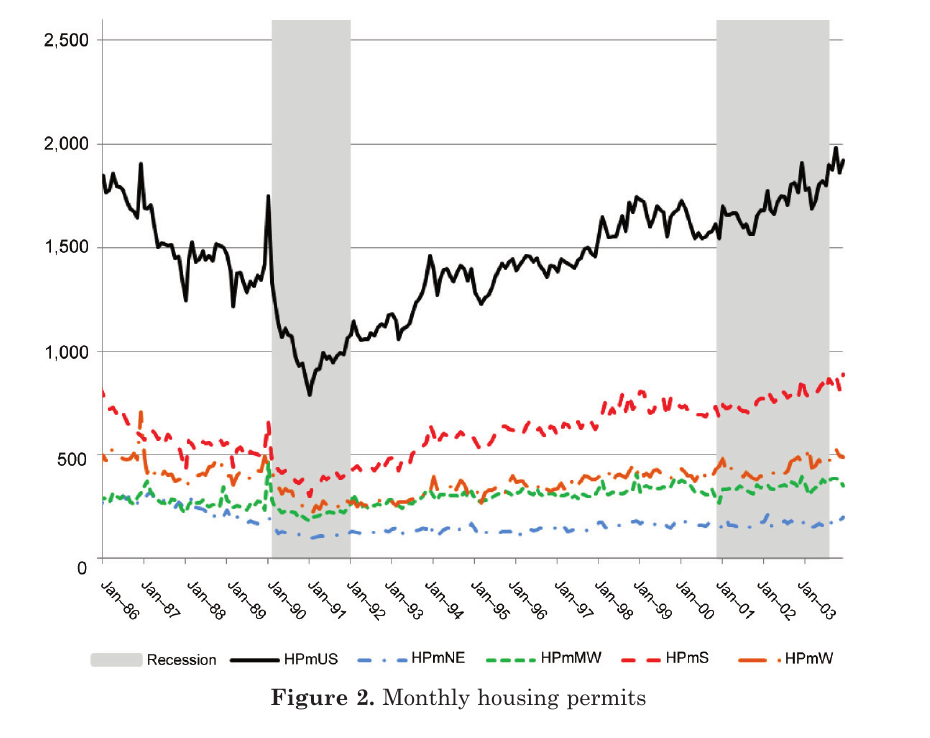
Figure 2. monthly housing permits